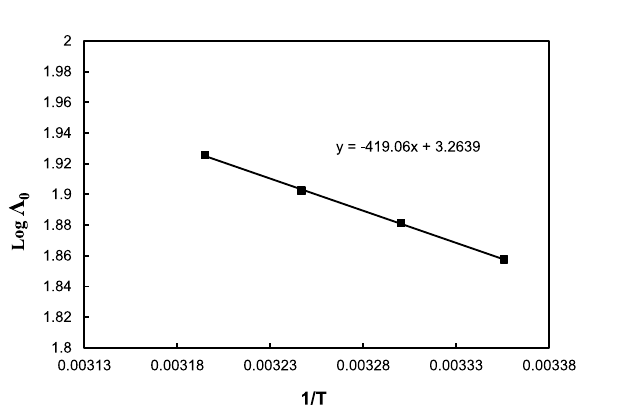
Figure 6. The variation of log Λ 0 versus 1/T for Sodium N , N -Dimethyl dithiocarbamate in Dimethylformamide at different temperatures .